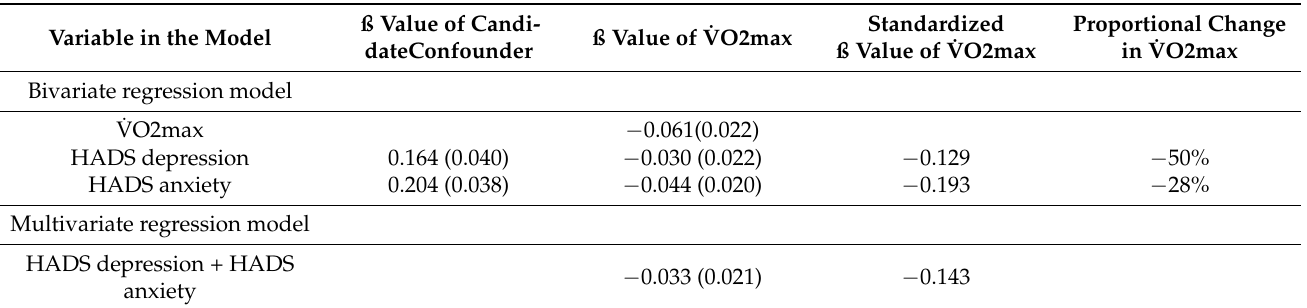
Table 3. Bivariate multilevel and multivariate regression model to test the effect of confounders on the predictive value of ˙VO2max for fatigue at one year (N =